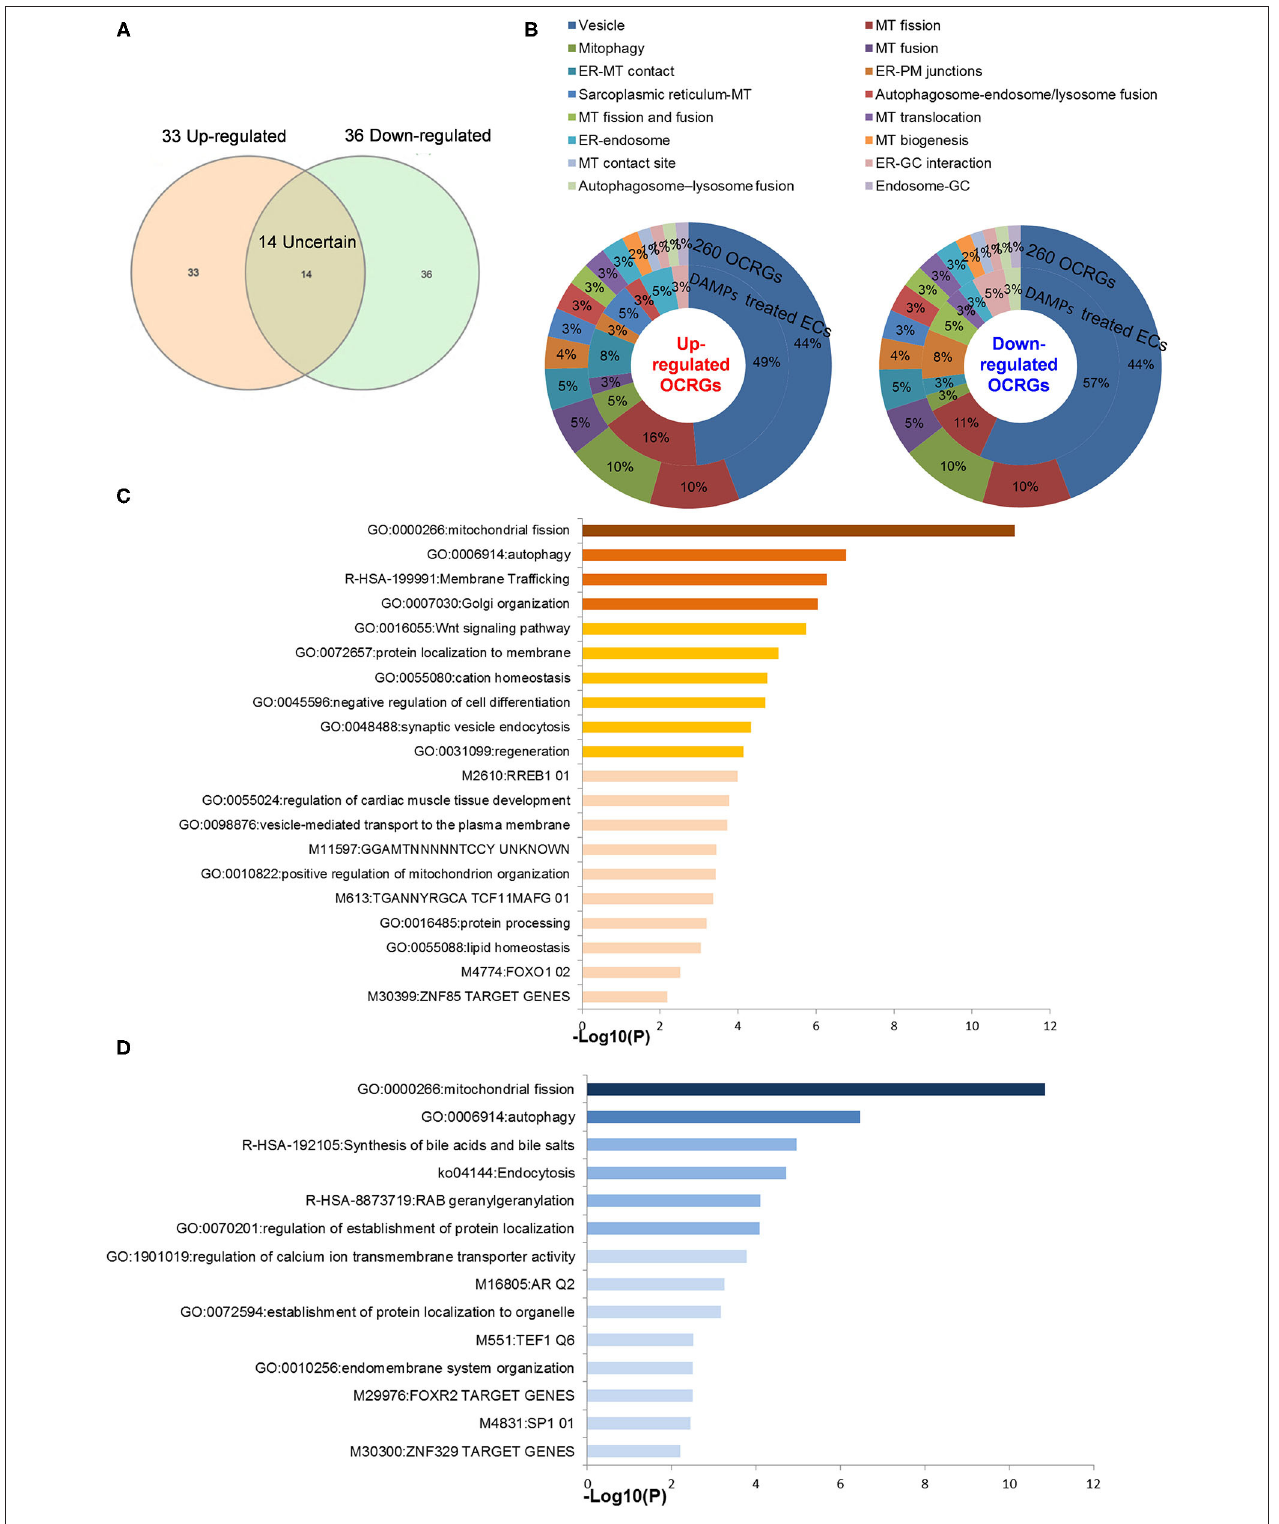
FIGURE 7 | Classifications of OCRGs differentially expressed in endothelial cells treated with pro-atherogenic DAMPs such as oxLDL, LPS, oxPAPC, and IFNs treated. (A) When the overlapped genes in all upregulated OCRGs and in all downregulated OCRGs were removed, 33 genes are upregulated and 36 genes are downregulated exclusively in inflammatory factor-treated endothelial cells. (B) Donut chart shows the ratio of classification of upregulated OCRGs (left) and